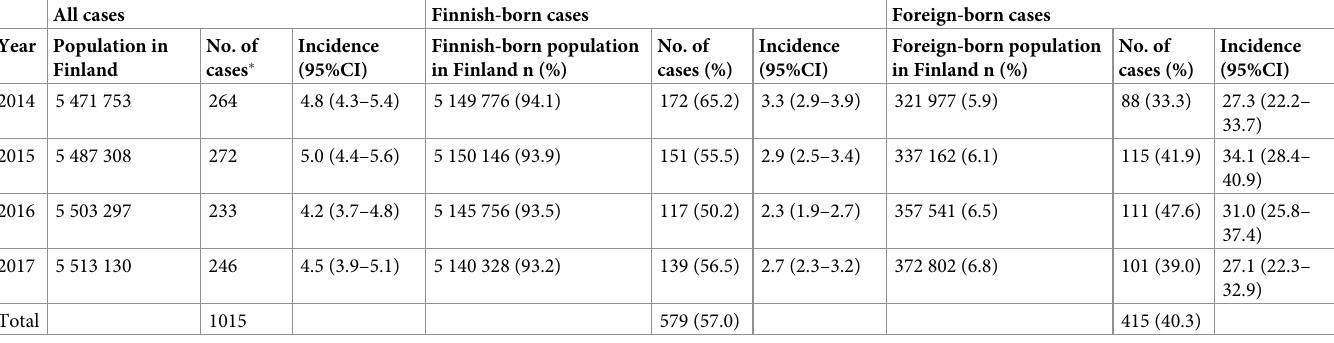
Table 2. Incidence of TB cases in the whole, Finnish-born and foreign-born populations in Finland, 2014–2017. All